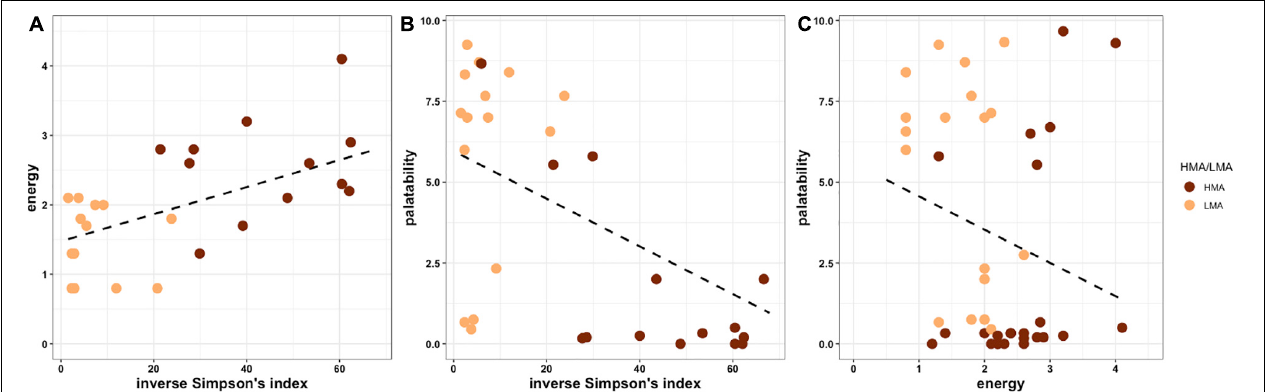
FIGURE 4 | Relationships between multiple life-history traits of sponges. (A) Tissue energy content ([KJ ml - 1 ] from Chanas and Pawlik, 1995) vs. microbiome diversity (inverse Simpson’s index; Easson and Thacker, 2014; Thomas et al., 2016; Gantt et al., 2019; Freeman et al., 2020); (B) Palatability (mean number of pellets containing sponge chemical extracts that were consumed in trials with the bluehead wrasse Thalassoma bifasciatum ; Loh and Pawlik, 2014) vs. microbiome diversity; (C) Palatability vs. energy.